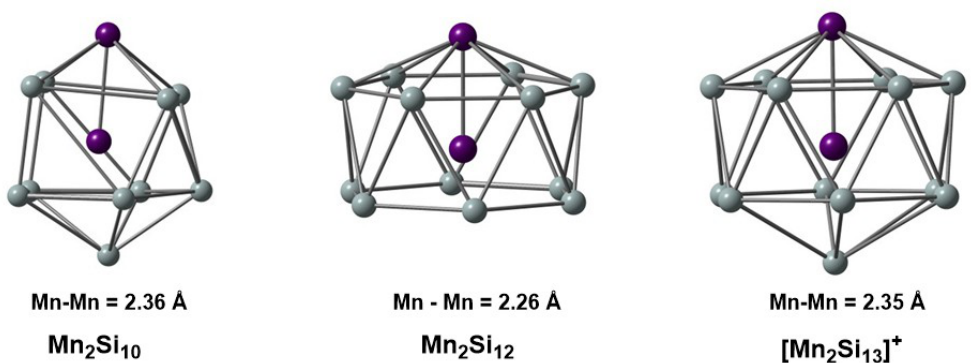
Figure 1. Structures of the Mn lengths are given in